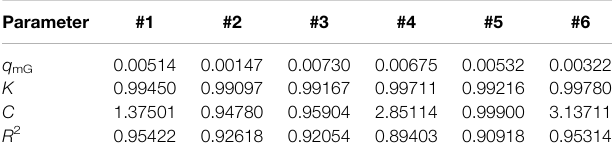
TABLE 3 | Fitted results of the GAB model for the various samples.